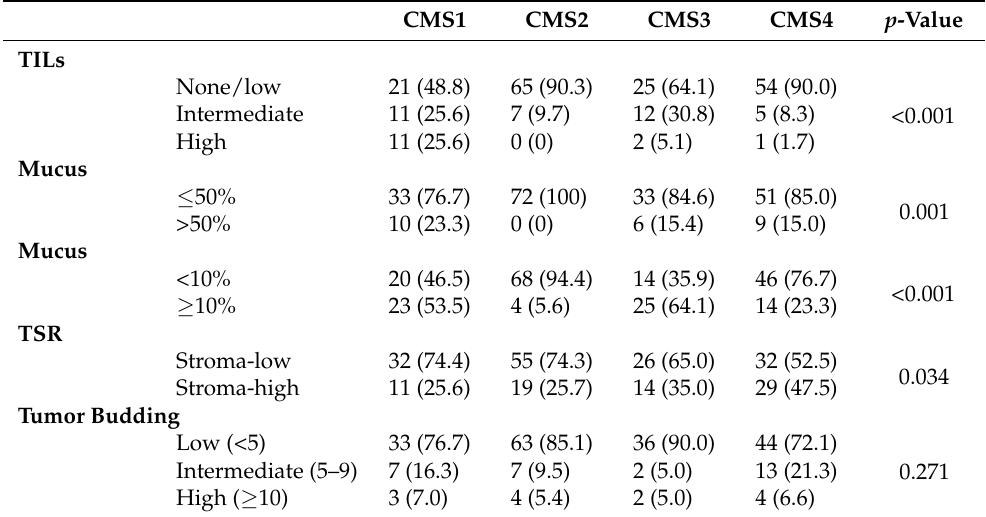
Table 2. Distribution of histopathologic features within the consensus molecular subtypes, shown as number and percentage. TILs = tumor infiltrating lymphocytes, TSR = tumor-stroma ratio. p -values are derived from an overall comparison between subtypes.